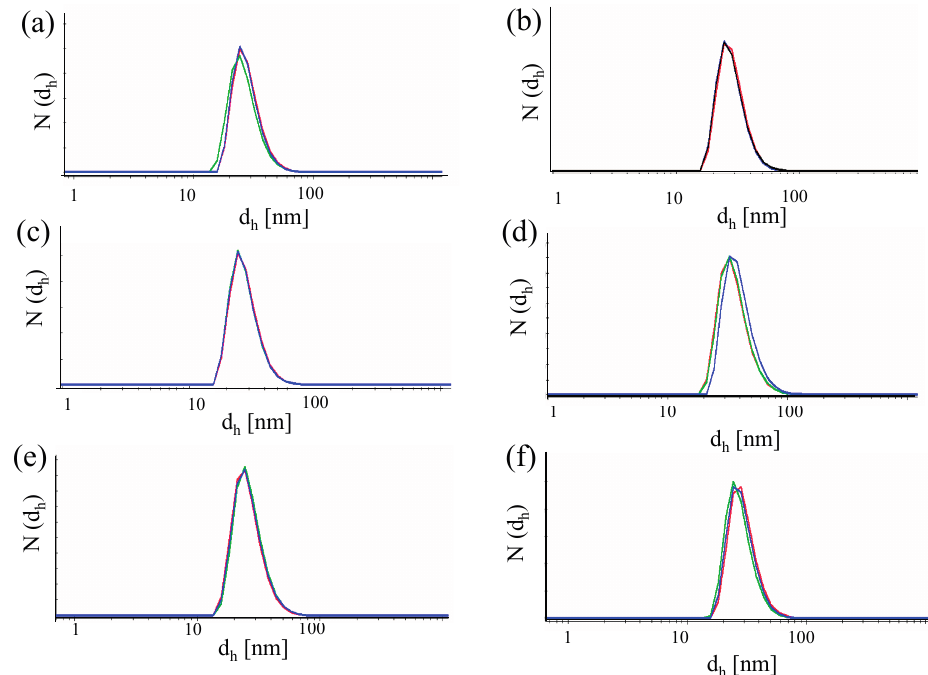
Figure 9. Number distribution N ( d h ) of the hydrodynamic diameter recorded or different NPs. ( a ) Au-PEG NPs, ( b ) Au-PEG-control NPs, ( c ) Au-PEG-anti-HRP* NPs, ( d ) Au-PEG-anti-VEGF* NPs, ( e ) Au-PEG-anti-HRP NPs, and ( f ) Au-PEG-anti-VEGF NPs. The concentration of the NP solutions were c NP ≈ 5 nM, and the measurements were performed in milliQ water. Each sample was measured at least three times and the mean value of the hydrodynamic diameter was determined.